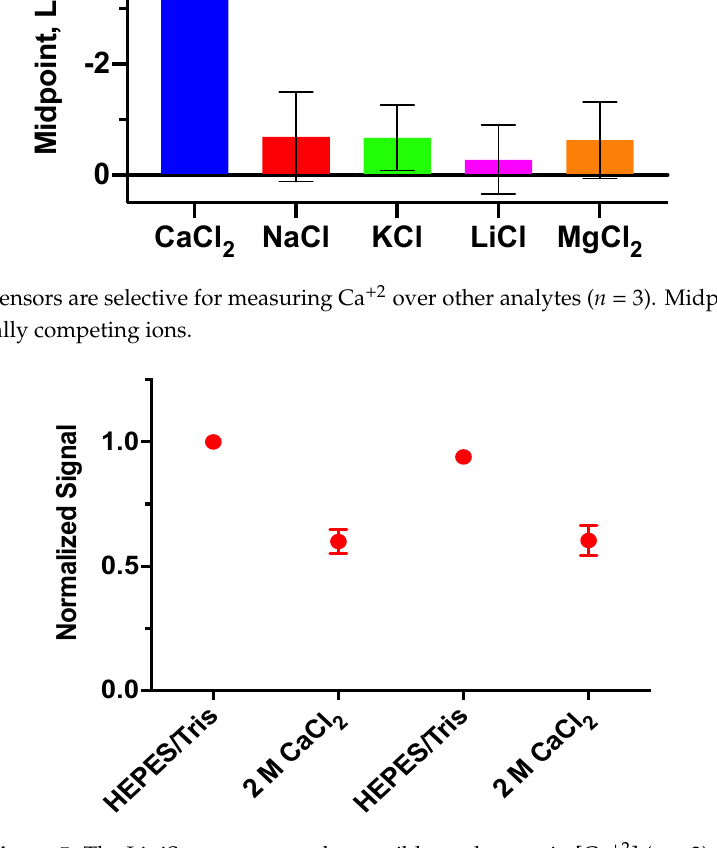
Figure 5. The LipiSensors respond reversibly to changes in [Ca +2 ] ( n = 3).